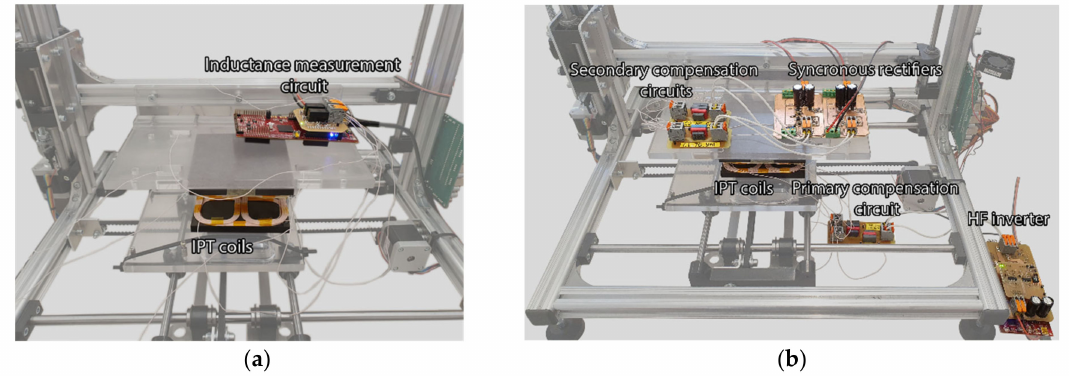
Figure 6. Experimental set bench: ( a ) the coupling coefficent measurement set bench; ( b ) the IPT system set bench.